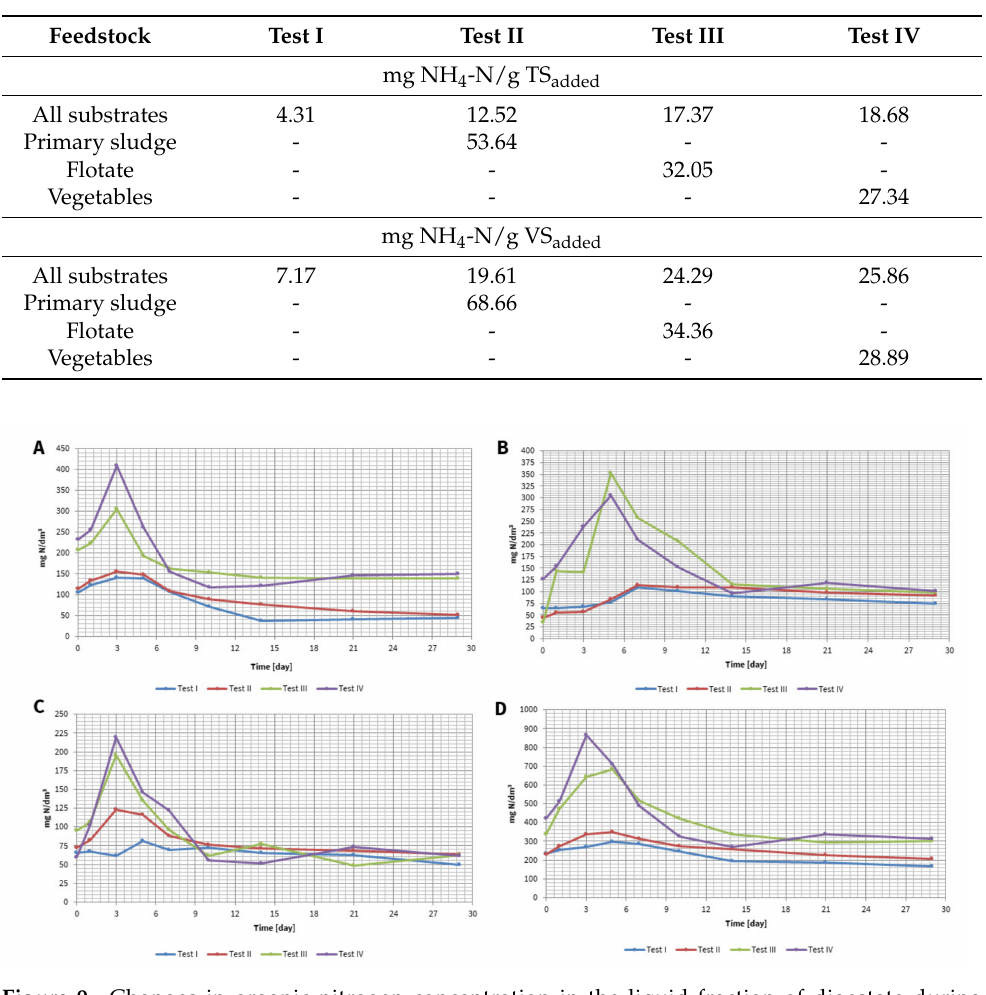
Figure 9. Changes in organic nitrogen concentration in the liquid fraction of digestate during co-fermentation tests: ( A ) DON; ( B ) CON; ( C ) PON; ( D ) ON. Final organic nitrogen fraction concentrations for test I were 44.0, 75.0, and 49.3 mgN/dm 3 , for DON, CON, and PON, respectively. The addition of primary sludge (in the proportion of 80:20% by volume) contributed only to a slight increase in the final concentrations of ON fractions by 8, 17, and 12 mgN/L, for DON, CON, and PON, respectively. Moreover, for the reject water from the digested sludge dewatering in two large WWTPs in Northern Poland, significantly higher CON values were observed in relation to DON, but their concentrations were almost two times lower than the values obtained in test II (24.0–29.5 mg DON/dm 3 and 33.7–38.5 mg CON/dm 3 , respectively)